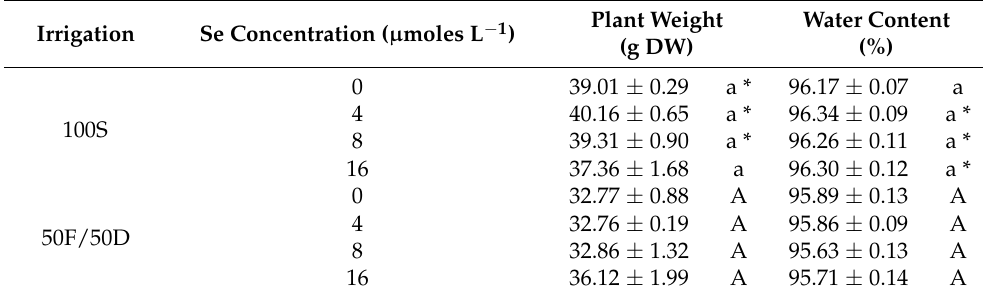
Table 1. Effect of different selenium concentration (0, 4, 8, and 16 µ moles L − 1 ) and two types of irrigation water (100S or 50F/50D) on plant dry weight and percentage of water content. Plant Weight Water Content Irrigation Se Concentration ( µ moles L − 1 ) (g DW) (%) 0 39.01 ± 0.29 a * 96.17 ± 0.07 a 4 40.16 ± 0.65 a * 96.34 ± 0.09 a * 100S 8 39.31 ± 0.90 a * 96.26 ± 0.11 a * 16 37.36 ± 1.68 a 96.30 ± 0.12 a * 0 32.77 ± 0.88 A 95.89 ± 0.13 A 4 32.76 ± 0.19 A 95.86 ± 0.09 A 50F/50D 8 32.86 ± 1.32 A 95.63 ± 0.13 A 16 36.12 ± 1.99 A 95.71 ± 0.14